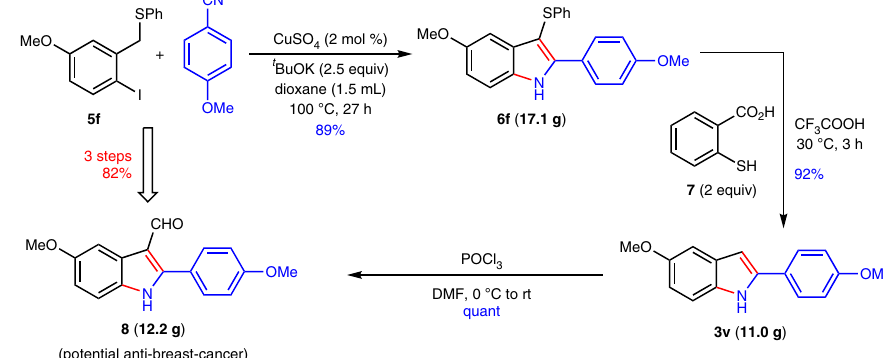
Fig. 7 Large-scale synthesis of pharmaceutical. A potential anti-breast cancer reagent 8 is synthesized from 5f in 10 gram-scale